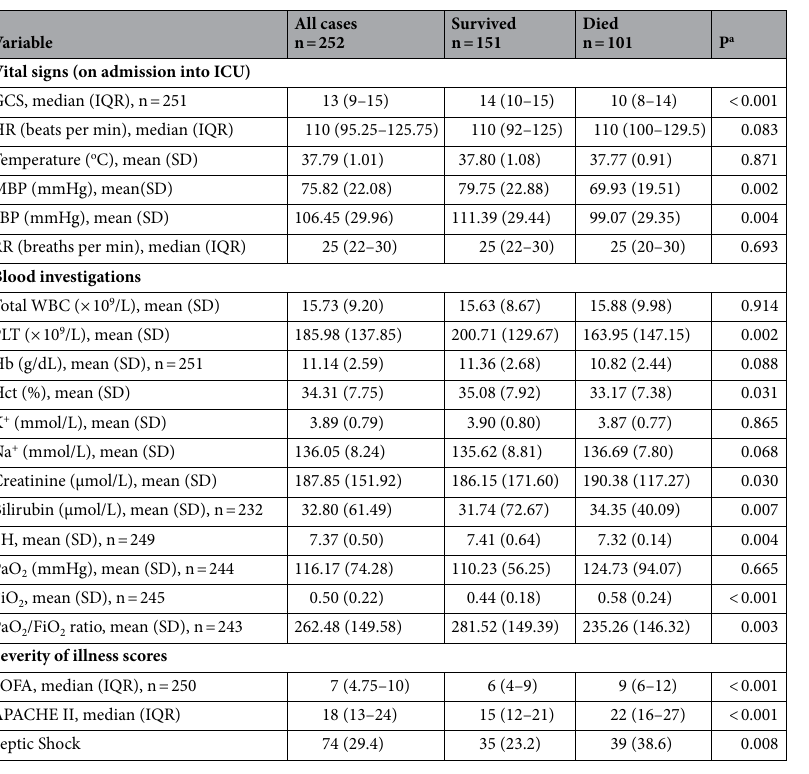
Table 3. Clinical and laboratory characteristics and severity of illness according to hospital survivability of patients with sepsis. APACHE II acute physiologic assessment and chronic health evaluation II, FiO 2 fraction of inspired oxygen, GCS Glasgow coma scale, Hb hemoglobin, Hct hematocrit, HDU high dependency unit, ICU intensive care unit, IQR interquartile range, MBP mean blood pressure, no. number, PaO 2 partial pressure of oxygen, PLT platelet, qSOFA quick sequential organ failure assessment, RR respiratory rate, SBP systolic blood pressure, SD standard deviation, SIRS systemic inflammatory response syndrome, SOFA sequential organ failure assessment, WBC white blood cell. a Comparison between survived and died patients with